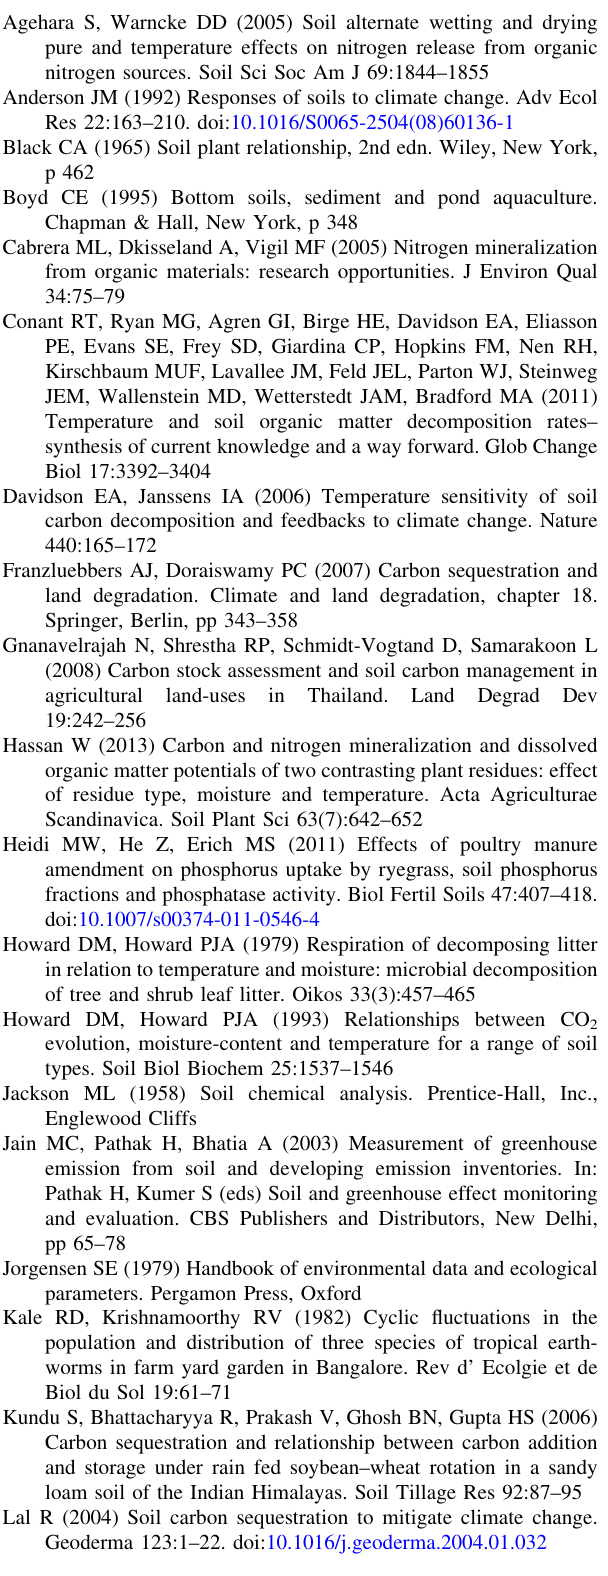
table position on carbon dioxide and methane emissions from laboratory columns of peatland soils. J Soil Sci